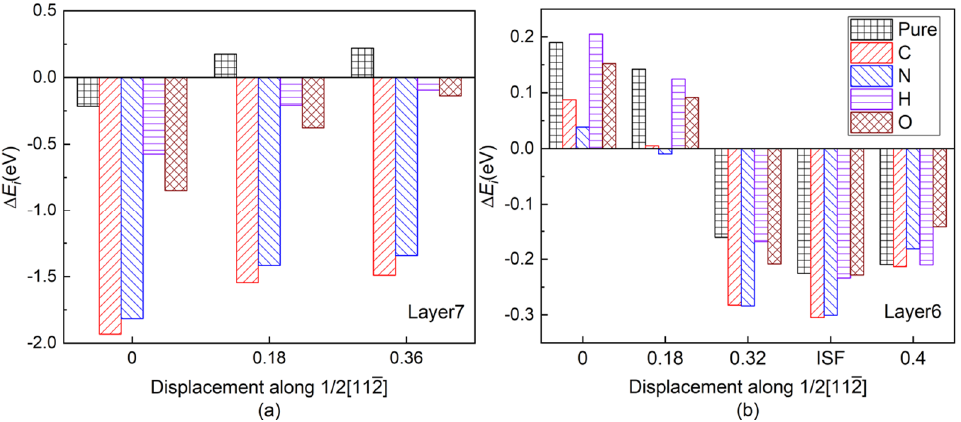
Figure 7. (Color on line.) Layer energy of Layer7 and Layer6 under different shearing displacement ( a ) Layer7 and ( b ) Layer6. The shearing displacement of ISFE is somewhat different for each interstitial atom.